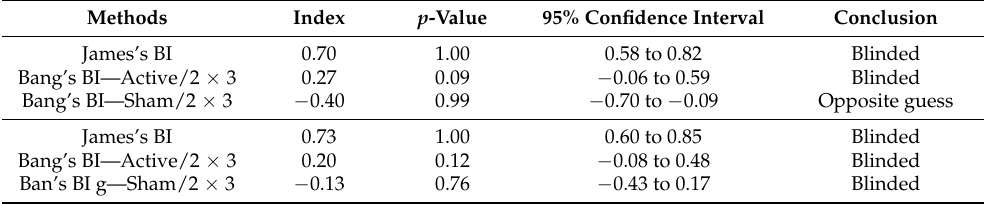
Table 5. James’ Blinding Index and Bang’s Blinding index of therapists (upper) and assessors